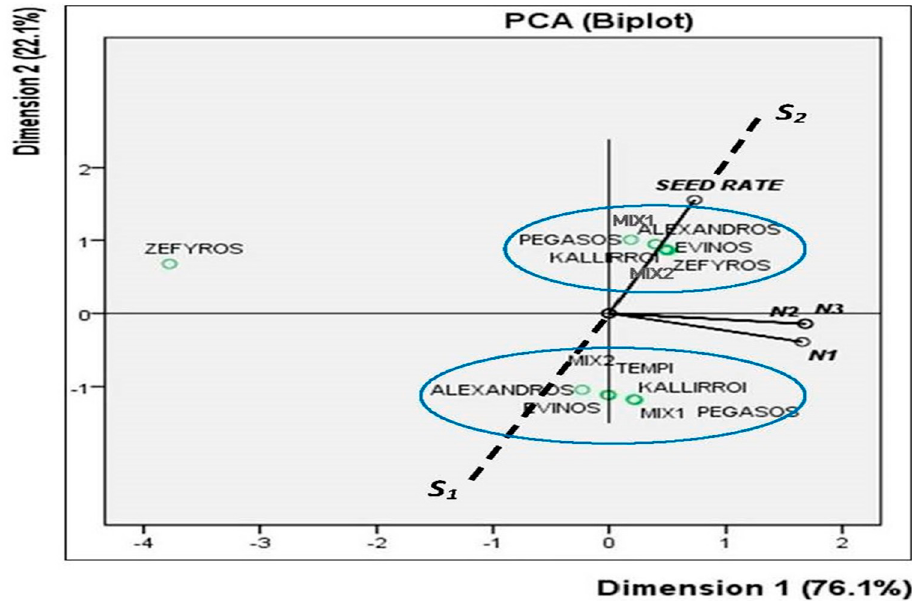
Figure 4. PCA biplot analyses of residual soil nitrogen two (N 1 ), four (N 2 ) and six months (N 3 ) after incorporation of biomass, for six cultivars and two mixtures of common vetch, at two seed rates (S 1 : 100 kg ha -1 ; S 2 :180 kg ha -1 ).